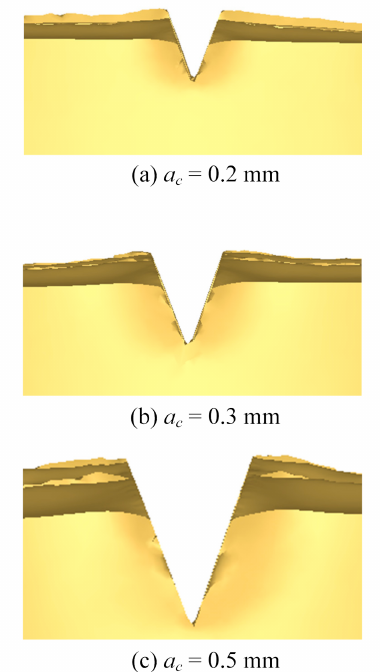
Figure 7. Morphology of microgrooves under di ff erent stamping depths in simulation. ( a ) a c = 0.2 mm; ( b ) a c = 0.3 mm; ( c ) a c = 0.5